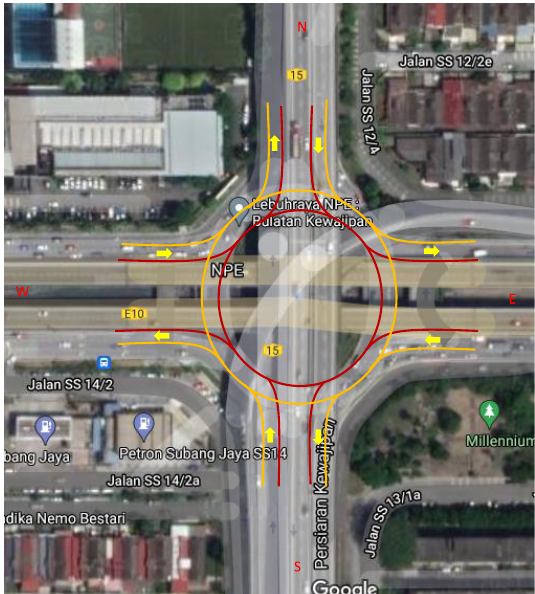
Figure 5. The study roundabout in Subang Jaya, Malaysia taken from the Google map. The outside lane of the roundabout is represented by the orange line and the inner lane is represented by the red